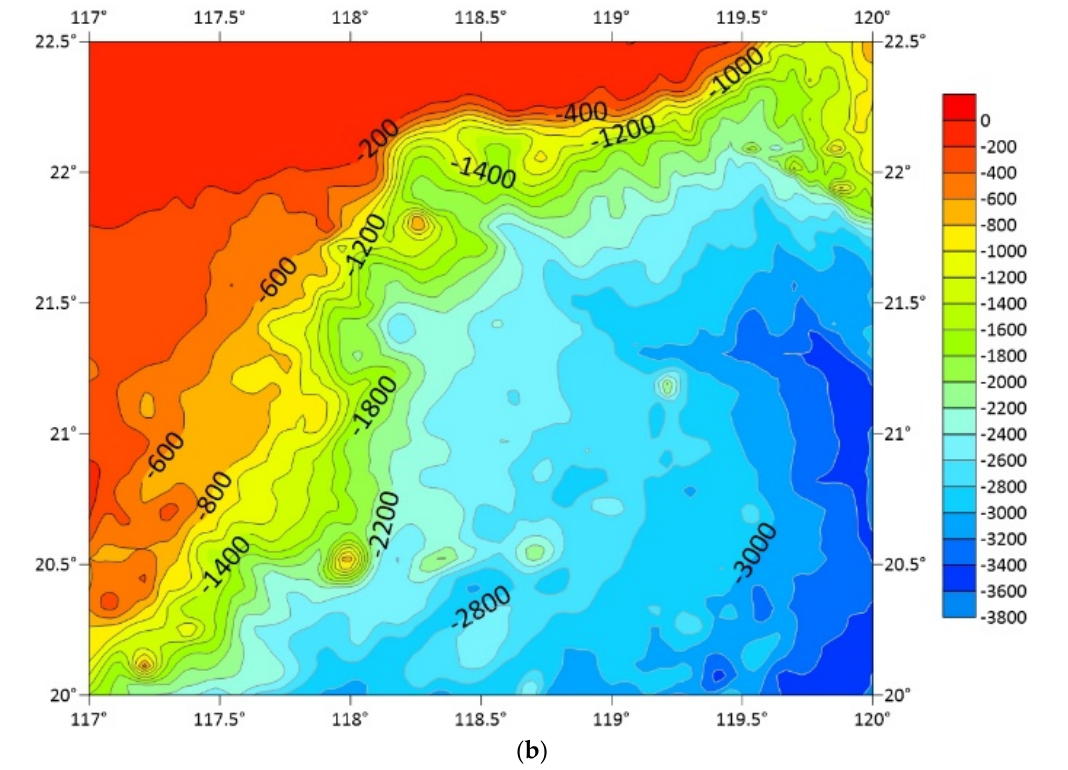
Figure 2. Seabed topography and landforms of research area towards abyss in this work. ( a ) The location of Dongsha area in northeastern SCS where GMGS2 and 973 field investigations have been carried out; ( b ) local bathymetric contour.